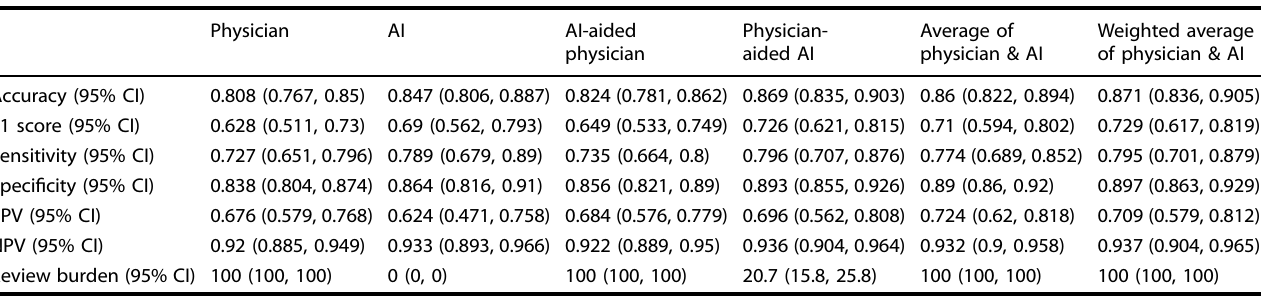
Table 2. Performance of the ARDS detection